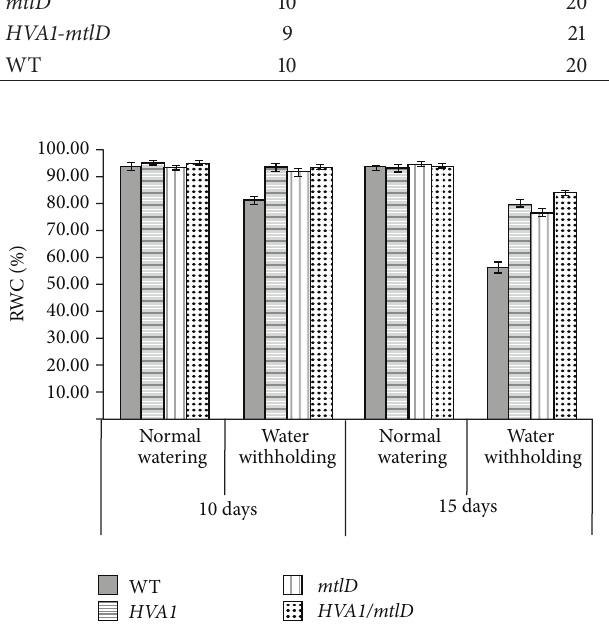
Figure 4: Percentage of leaf relative water content (% RWC) of the T3transgeniclinesafter10and15daysofwaterwithholding.Barsare mean ± SE of three samples. The percentages of least square means (LSMeans) are shown on the top of each